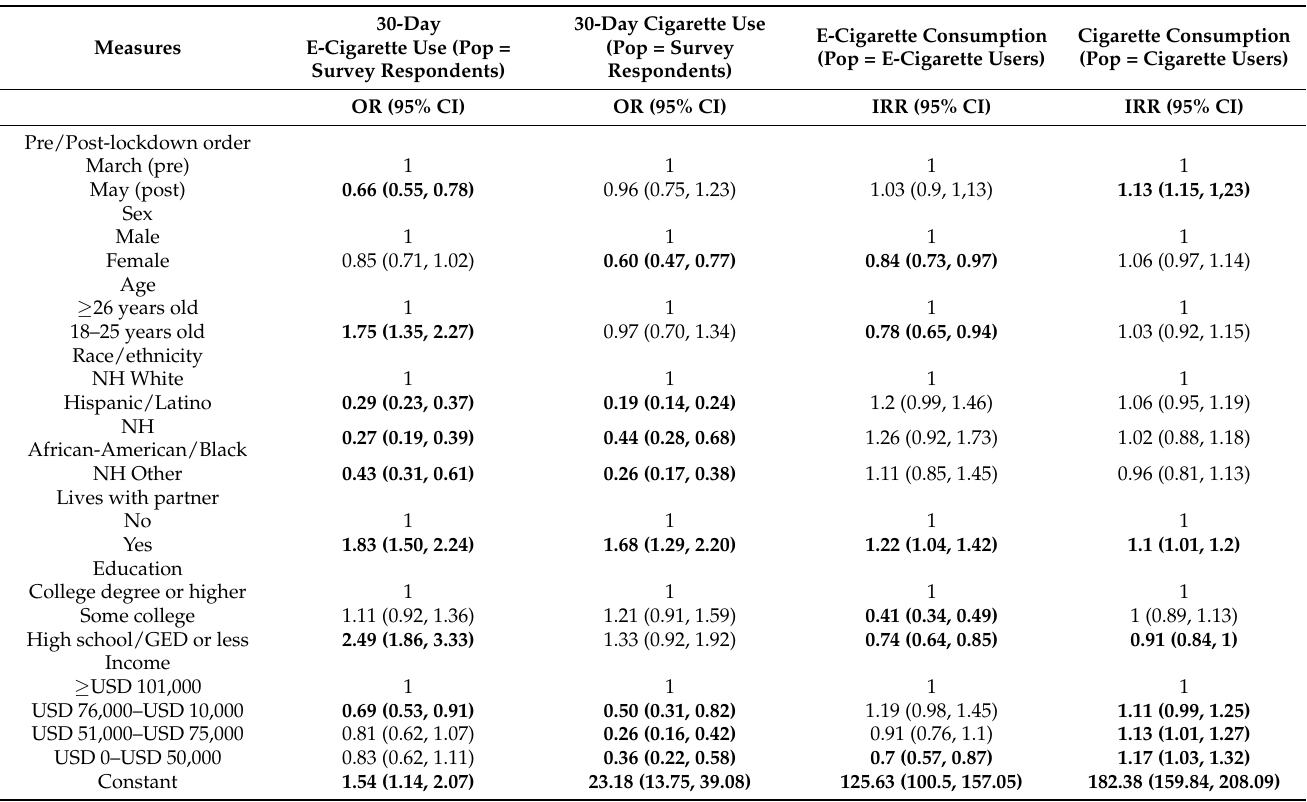
Table 2. Correlates of 30-day cigarette smoking, 30-day e-cigarette use, and cigarette and e-cigarette consumption rates ( n =